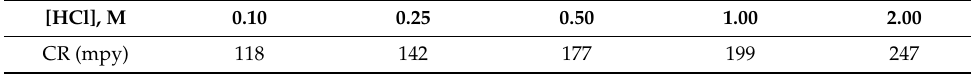
Figure 8. Effect of [HCl] on the CR of mild steel at 303 K. Table 3. Values of CR for mild steel in diverse [HCl] solutions at 303